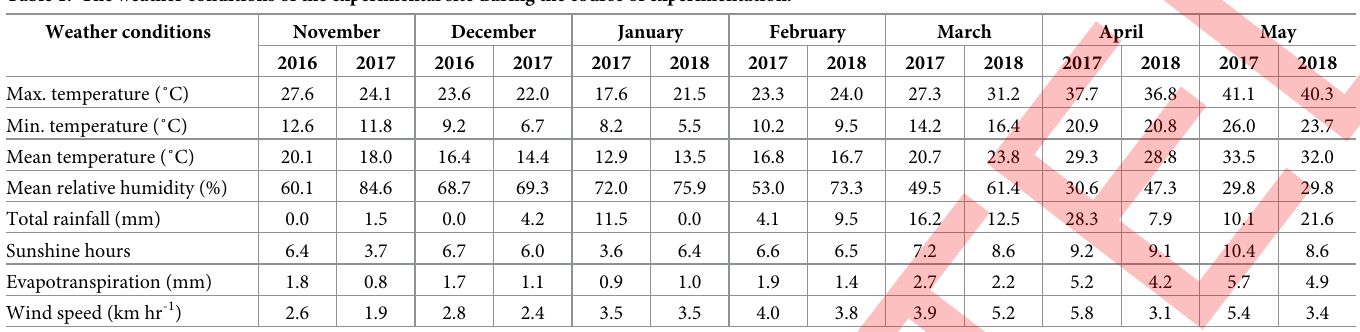
Table 1. The weather conditions of the experimental site during the course of